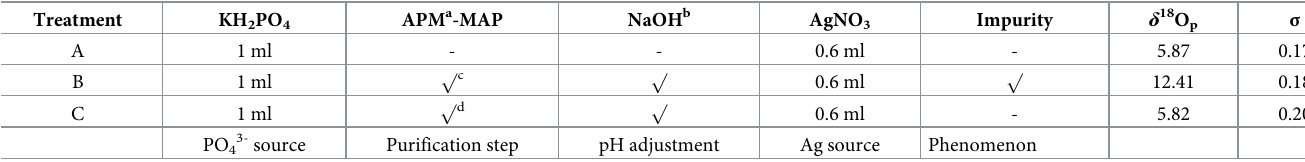
Table 2. Study on mechanism of gray black precipitation (n = 3).